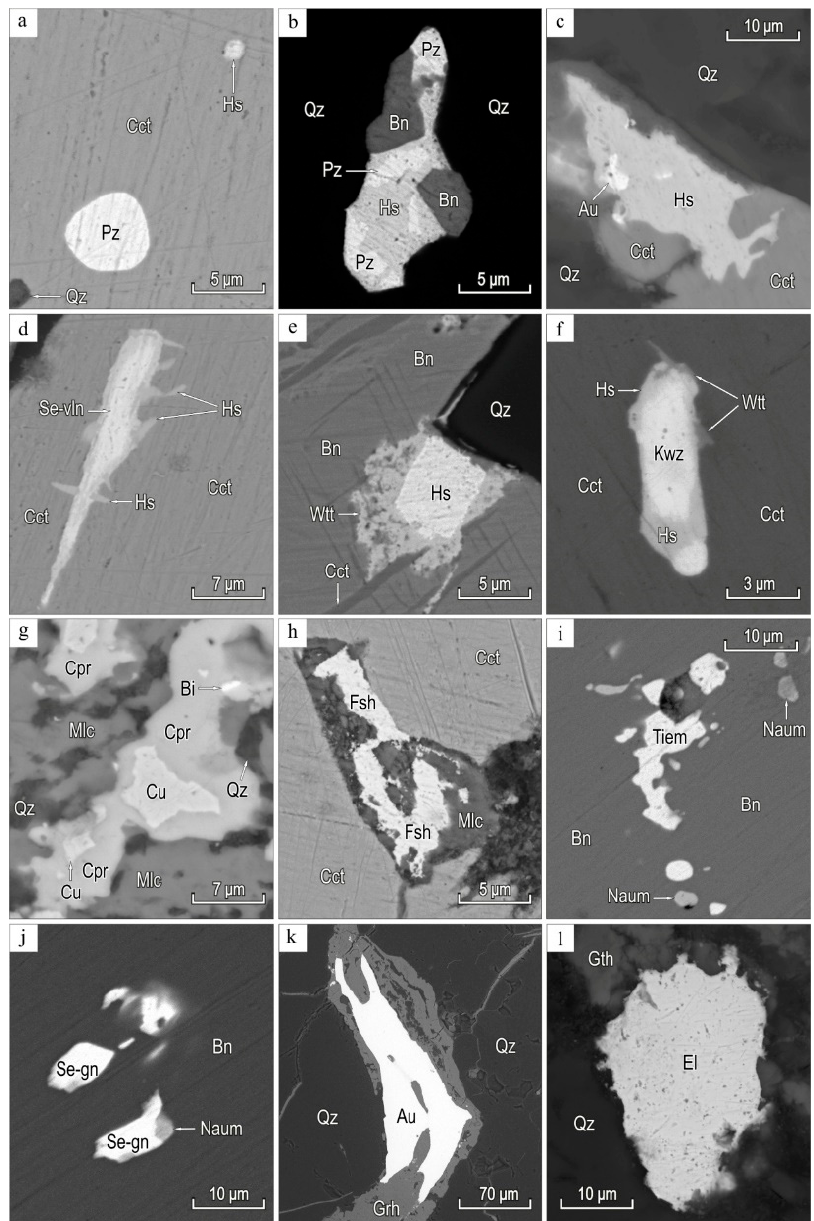
Figure 7. Minerals gold–telluride–sulfide–quartz veins: ( a ) inclusions of hessite (Hs), and petzite